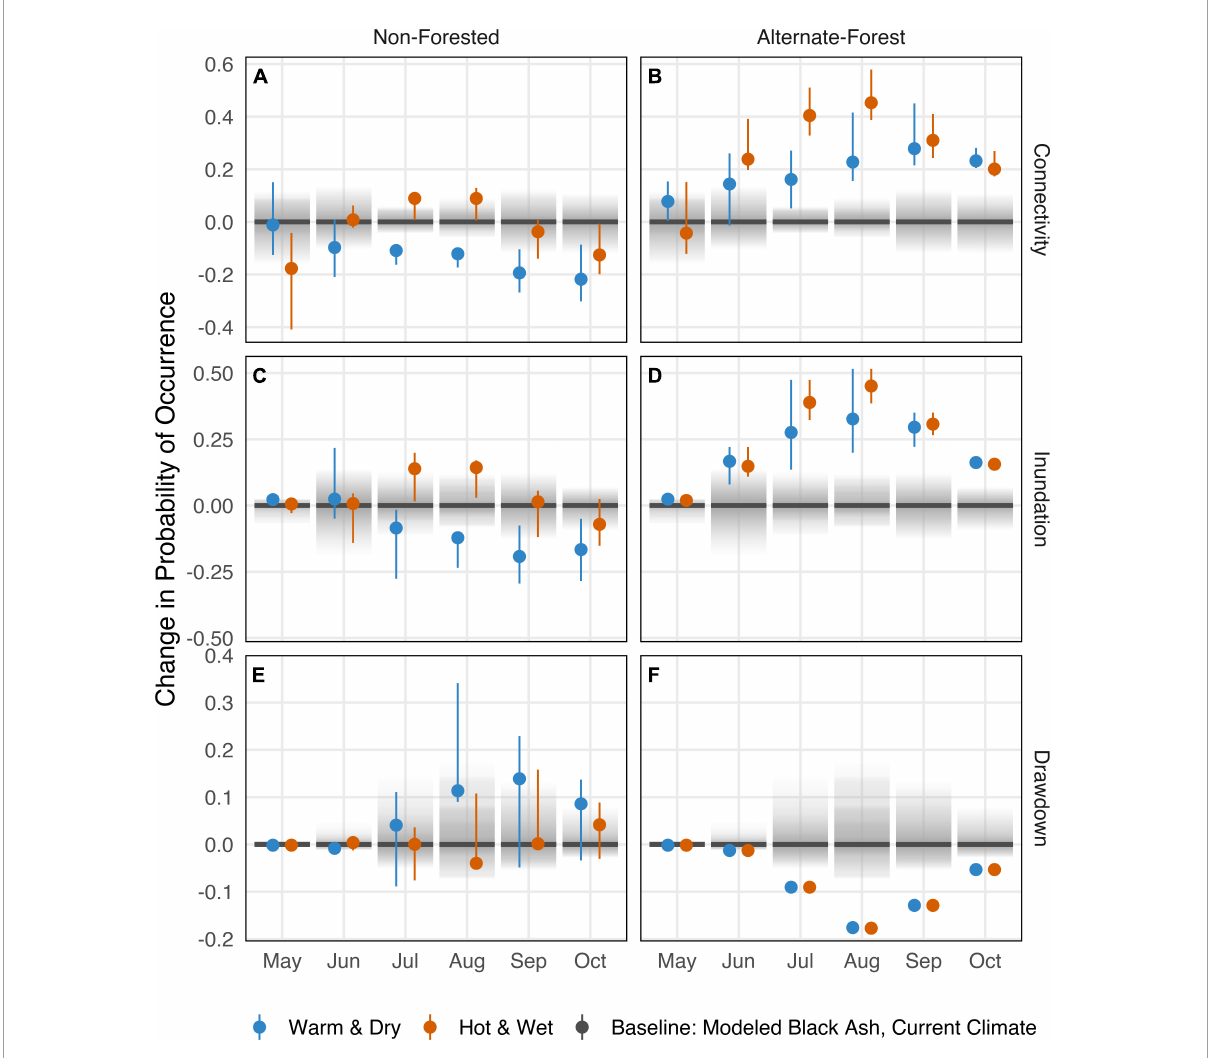
FIGURE5 Change in probability of water levels above (connectivity, inundation) or below (drawdown) ecohydrologically significant thresholds (CEHT) under future vegetation (non-forested or alternate-forested) and climate scenarios relative to baseline of black ash under a current climate where each combination of CEHT and future vegetation condition is identified in panels (A–F) . Probability of occurrence is the proportion of days in each month that simulated water levels reached and exceeded each threshold. Values are reported as the median (point/bar) and the bounds of a 67% highest density continuous interval (HDCI, an interval, potentially asymmetric, that contains 67% of simulated values). For some combinations of vegetation conditions and climate scenarios the HDCI may be indistinguishable from the point estimate because of the small range covered by the HDCI. Blue and orange colors represent warm & dry and hot & wet future climate scenarios, respectively. Gray shaded area represents 67% HDCI of model simulations for control black ash conditions under the current climate (baseline condition) and the black crossbar represents the baseline monthly median probability (centered to